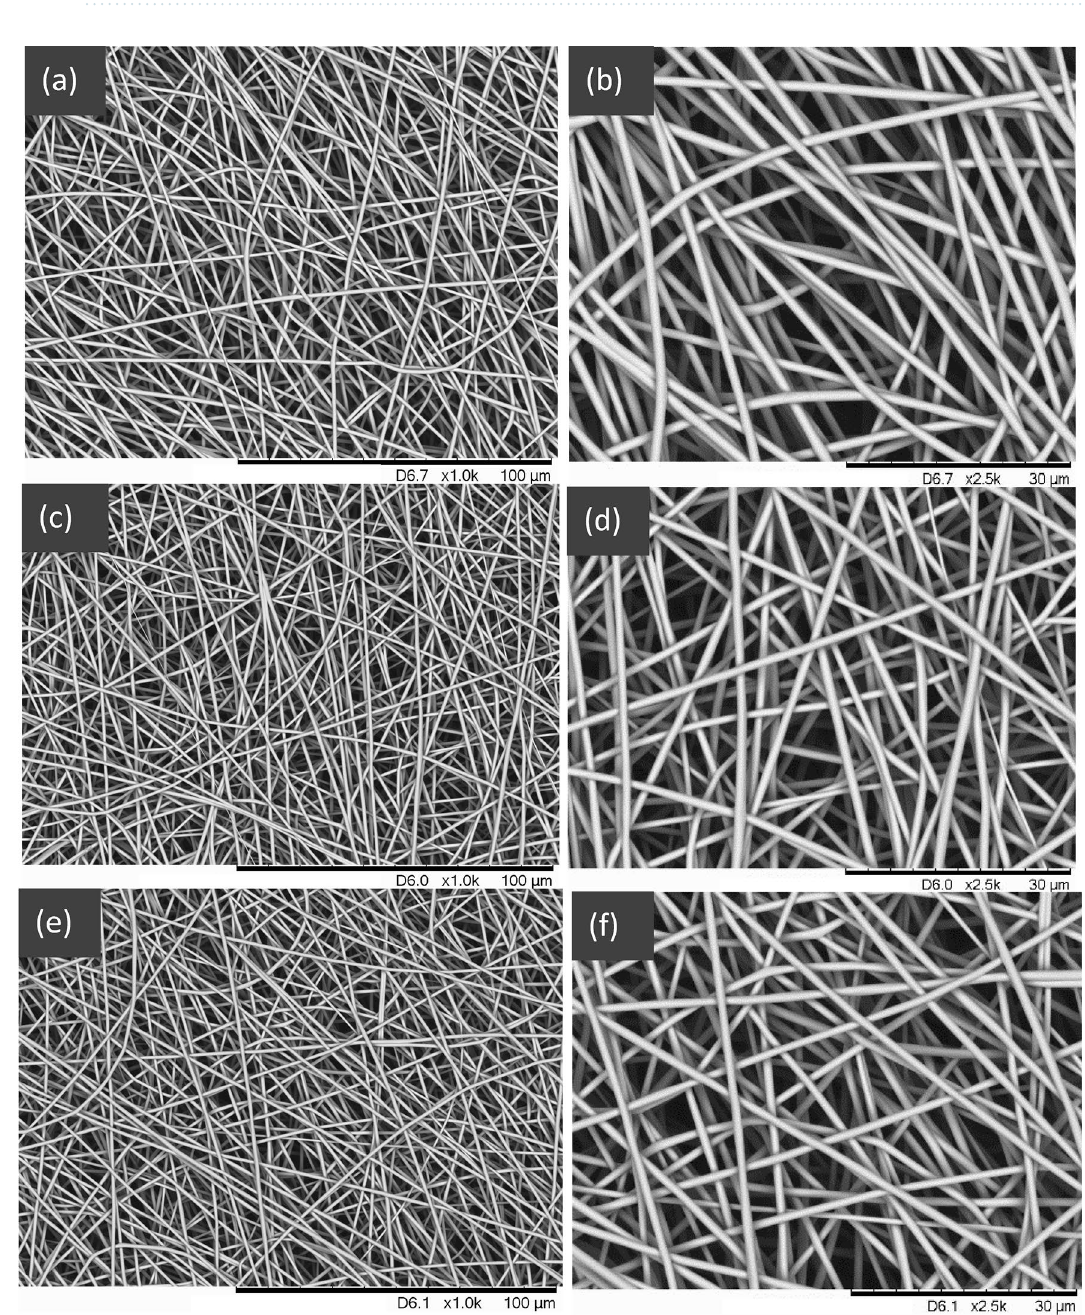
Figure 4. Electro-spun and carbonised (ASL-ESL) lignin fibres after carbonisation at 1000 °C ( a , b ), 1200 °C ( c , d ) and 1500 °C ( e , f ) with magnifications of × 1000 and ×